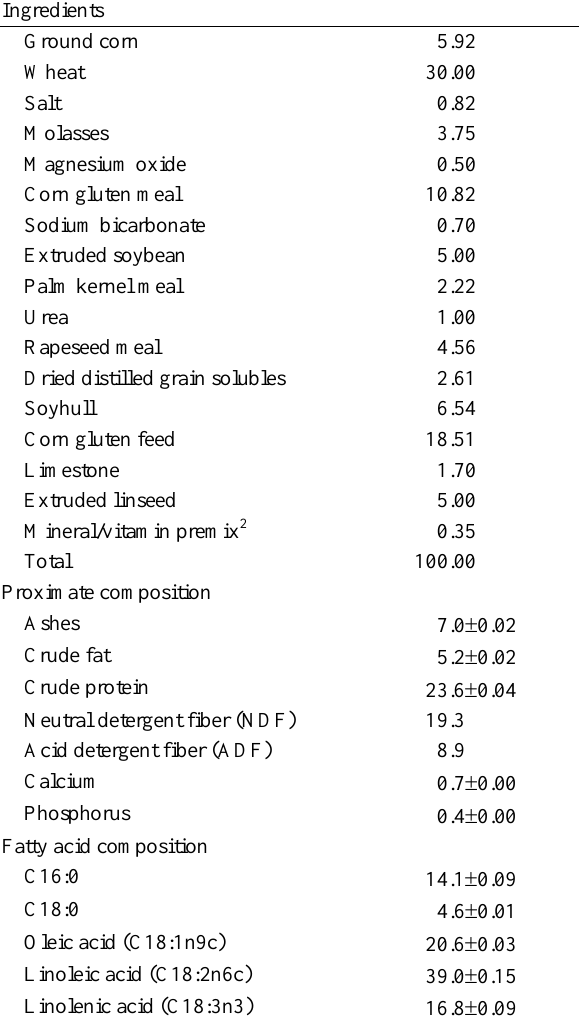
Table 3. Ingredients (% dry matter), proximate (% dry matter) and fatty acid (% total fatty acids) composition of the concentrate